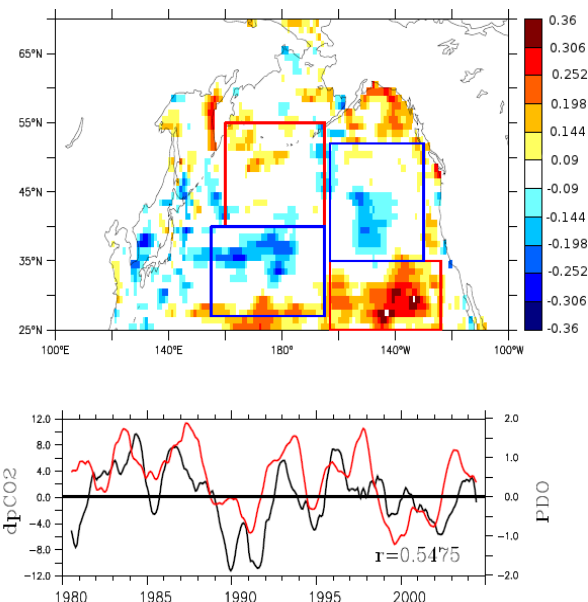
Fig. 5. (Top): Correlation coefficients between the interannual vari- 3 ability of δp CO 2 and the PDO index (negative δp CO 2 means atmo- Figure 5: (Top): Correlation coefficients between the interannual variability of δpCO 2 and the PDO 4 index (negative δpCO 2 means atmospheric pCO 2 exceeds that of the ocean). Correlations significant at 5 spheric p CO 2 exceeds that of the ocean). Correlations significant at 90% confidence interval are shaded. (Bottom): δpCO 2 index corresponding to PDO (black line) and 6 90% confidence interval are shaded. (Bottom): δp CO 2 index cor- PDO index (red line). δpCO 2 data from assimilation are used. Time series are smoothed by 12-months 7 responding to PDO (black line) and PDO index (red line). δp CO 2 running mean. Correlation is significant (using a 95% confidence interval). 8 data from assimilation are used. Time series are smoothed by 12- 9 months running mean. Correlation is significant (using a 95% con- fidence interval).